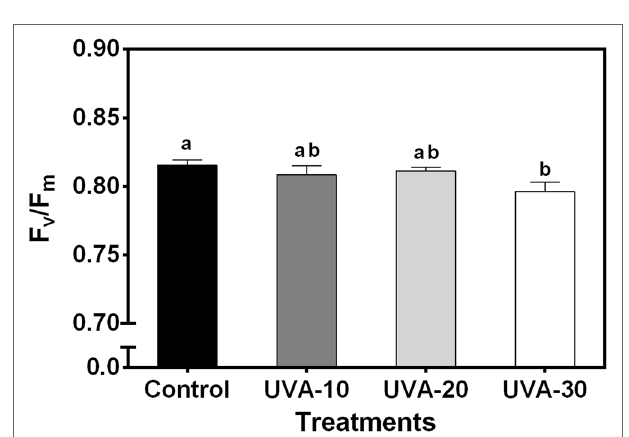
FIgURe 4 | Effects of UVA on maximum quantum efficiency of photosystem II photochemistry (F v /F m ) of lettuce leaves. Error bars show ± SE (n = 5). Letters show statistically significant differences ( P < 0.05 ).